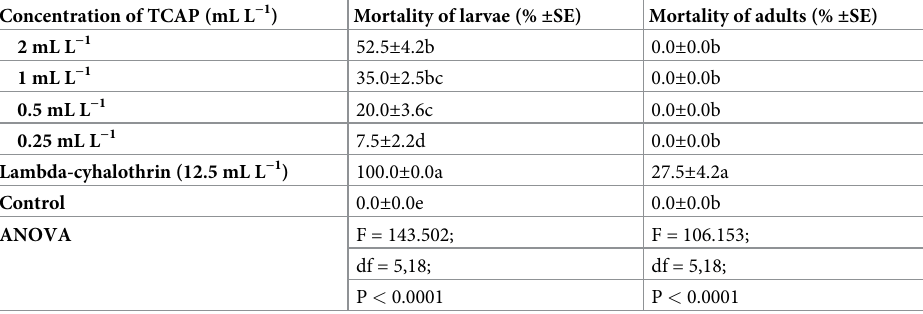
Table 3. Acute toxicity of TCAP against the larvae and adults of H . axyridis .